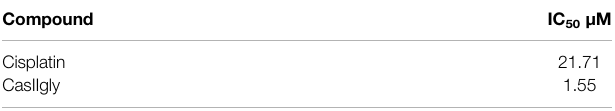
*Data represent the average of three independent